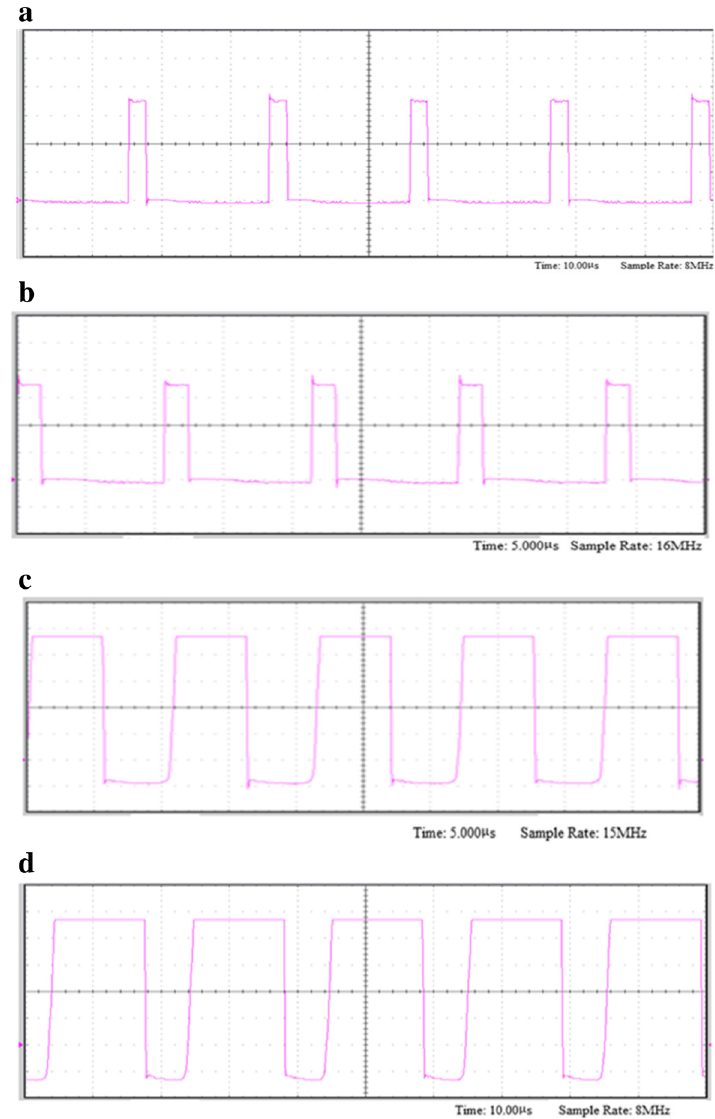
Fig. 8 Changing Duty cycles at different power ( a , b , c and d ) (time ranges from 5-10 μ s and sample rate from 8-16